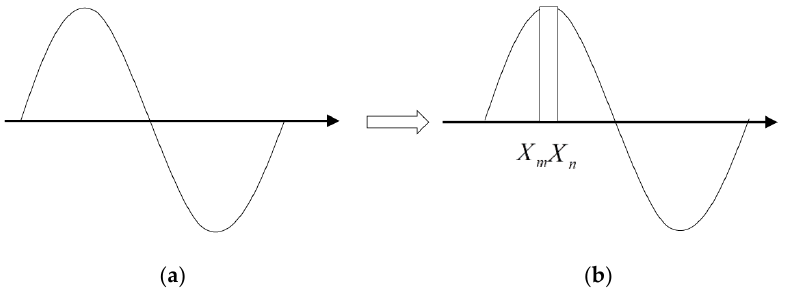
Figure 10. The fatigue load waveform recorded by LabVIEW. ( a ) Waveform without crack propagation; ( b ) waveform with crack propagation.